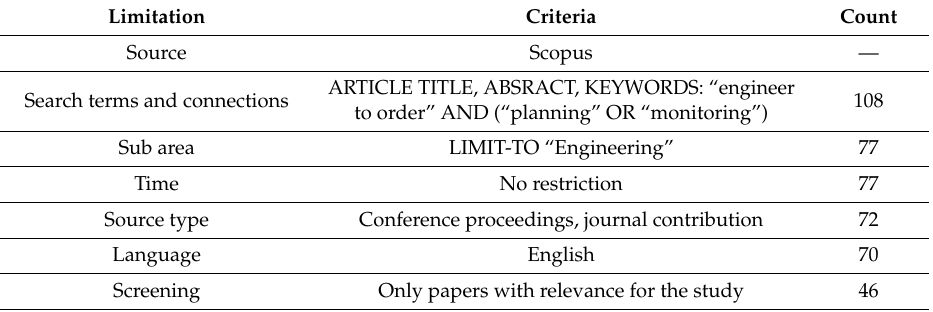
Table 1. Inclusion and exclusion criteria of the literature review.